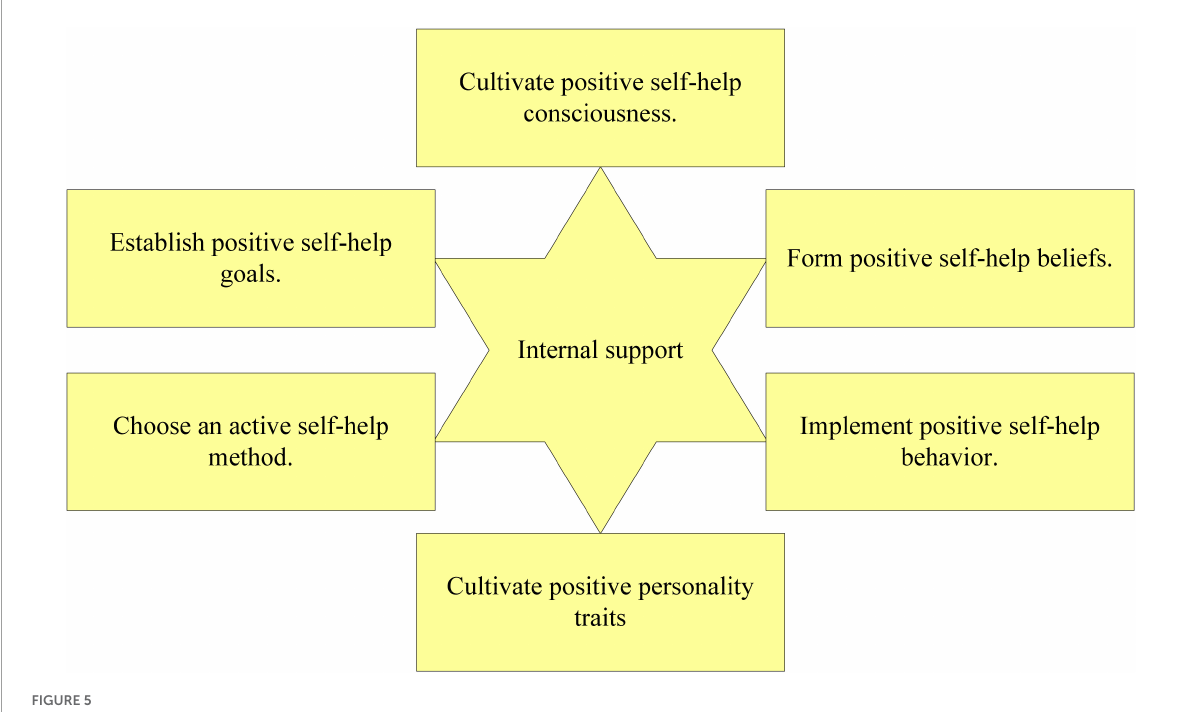
FIGURE5 Psychological internal support